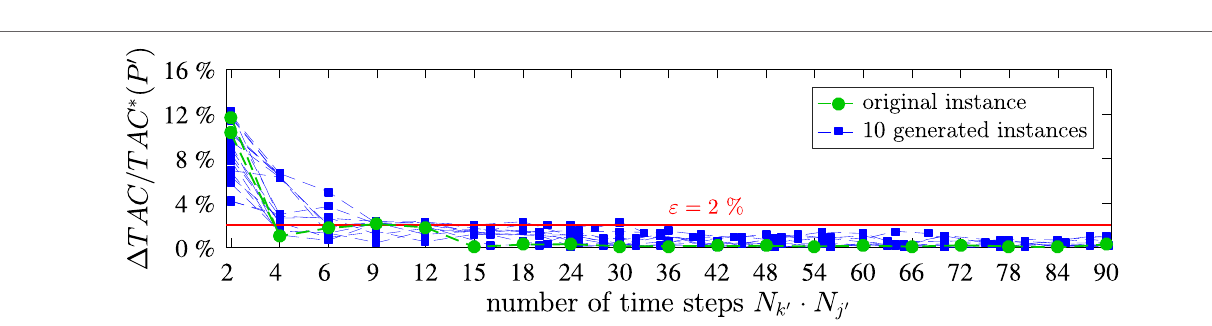
FIGURE 7 | Normalized accuracy measure ∆ TAC divided by total annualized cost of the aggregated synthesis problem TAC *( P ′ ) as function of number of time steps ( ) N k ′ · N j ′ for the original instance and 10 generated instances, threshold value of " =2% as solid red line.